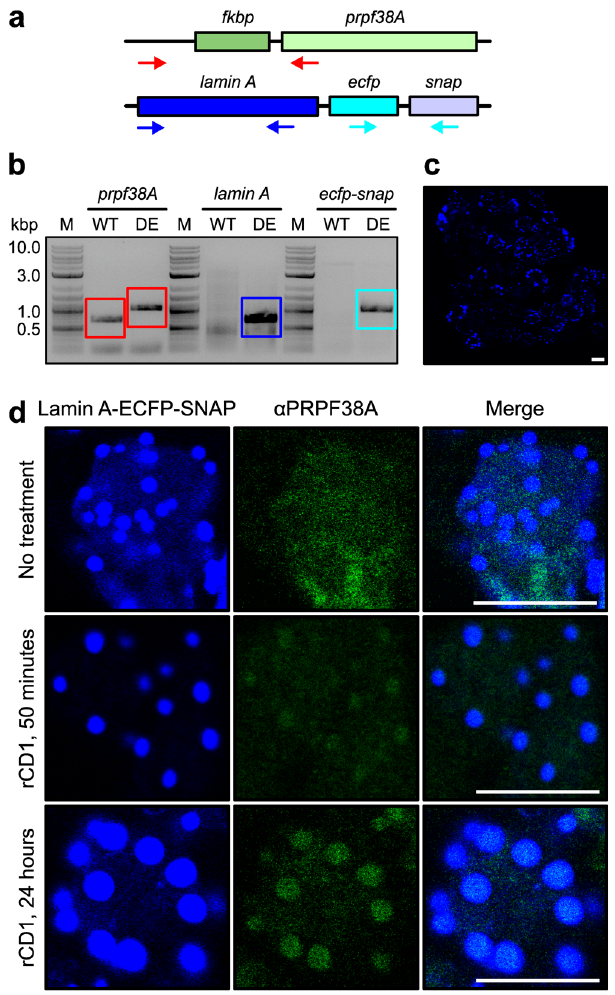
Fig. 5 Generation of a doubly engineered FKBP-PRPF38A CRISPR/lamin A-ECFP-SNAP stable cell line. a Schemes depicting primer pairs (arrows; Supplementary Table S1) used in the experiments shown in b . b PCR analysis of the genomic DNA of a doubly engineered FKBP-PRPF38A CRISPR/lamin A-ECFP-SNAP stable cell line, revealing the presence of the insertion of the FKBP-coding region and additional stable integration of the lamin A-ECFP-SNAP-coding region. Ampli fi ed products are boxed in colors corresponding to the primer pairs in a . WT wild-type HEK293T cells; DE doubly engineered FKBP-PRPF38A CRISPR/lamin A-ECFP-SNAP stable cells; M, size marker (kbp). c Immuno fl uorescence analysis of doubly engineered FKBP-PRPF38A CRISPR/lamin A-ECFP-SNAP stable cells, showing an ECFP fl uorescence signal (blue channel) consistent with the expression of the lamin A-ECFP-SNAP fusion protein. A scale bar (10 μ m) is shown as a white line on the bottom right of the image. d Untreated (top row) or rCD1-treated (middle row, 50 min; bottom row, 24 h) doubly engineered FKBP-PRPF38A CRISPR/lamin A-ECFP-SNAP stable cells were stained with anti-PRPF38A primary antibody and an Alexa488-coupled secondary antibody. Z-stacks were recorded, revealing the co-localization of FKBP-PRPF38A with lamin A-ECFP-SNAP at spherical lamin A-ECFP- SNAP aggregates only after rCD1 treatment. Scale bars (10 μ m) are shown as white lines on the bottom right of the merged